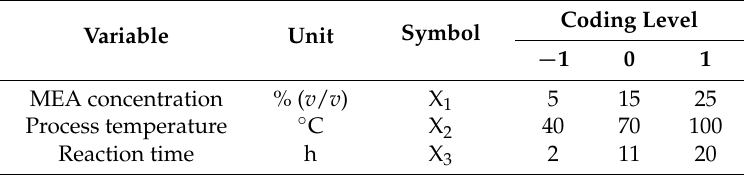
Table 3. Input variables for the Box-Behnken design during MEA pre-treatment.